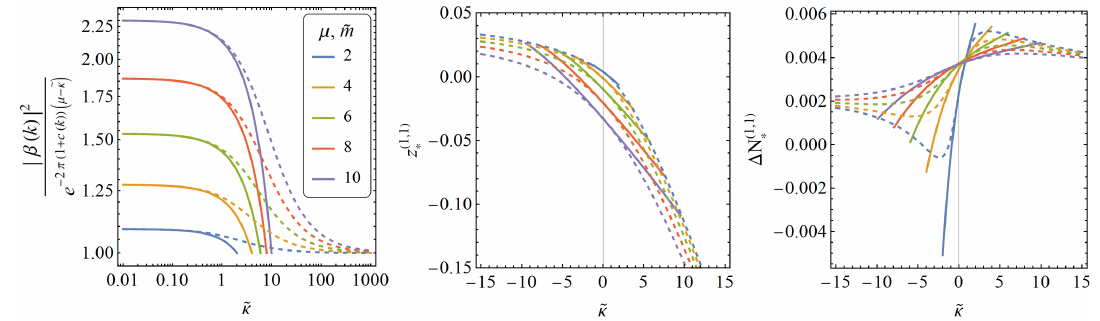
Figure 16 . The O ( c ( k ) η i ) corrections to production histories in deformed dS with c ( k ) = 0 . 05 and η i = 0 . 1 . Left panel: production amount excluding O ( η 0 ) contribution as a function of the dimen- i sionless chemical potential for different particle masses. Middle panel: the correction to z -domain production time dependence on chemical potential and mass. Right panel: the correction to pro- duction width measured in e-folding numbers. In all three plots, solid lines represent spin-1 bosons while dashed lines represent spin-1/2 fermions. Particles with different masses are distinguished by the colors of the lines according to the legend in the left panel. For bosons, we limit the range of chemical potential to be smaller than the mass, so that no tachyonic instability is induced. For fermions, the chemical potential is not restricted and we allow it to take arbitrarily large values.